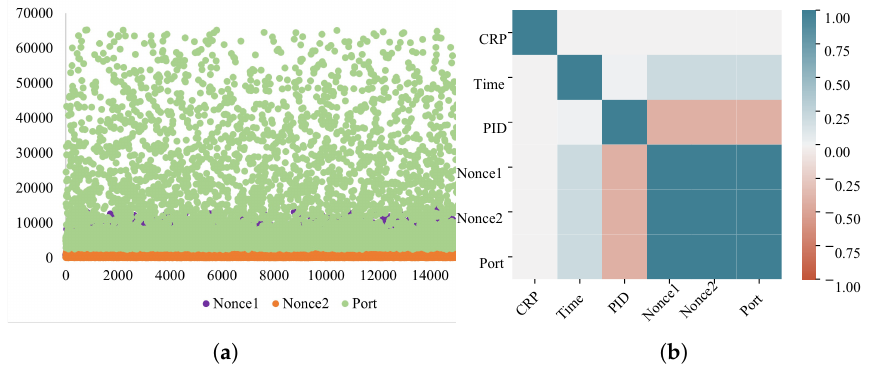
Figure 13. Input and output features of validation data of AdaDelta model (five layers) with Z-score: ( a ) output features distribution; ( b ) correlation map.